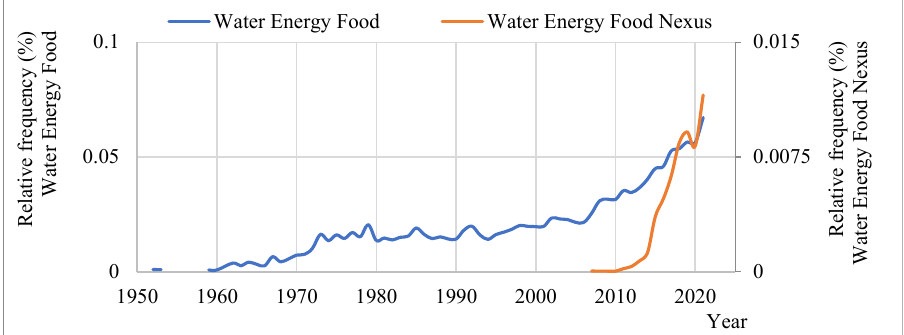
Figure 2. Relative frequency of appearances of the indicated key phrases in the article titles, abstracts and keywords of about 70 million articles written in English, which are contained in the Scopus database up to 2021 (data from [22]).